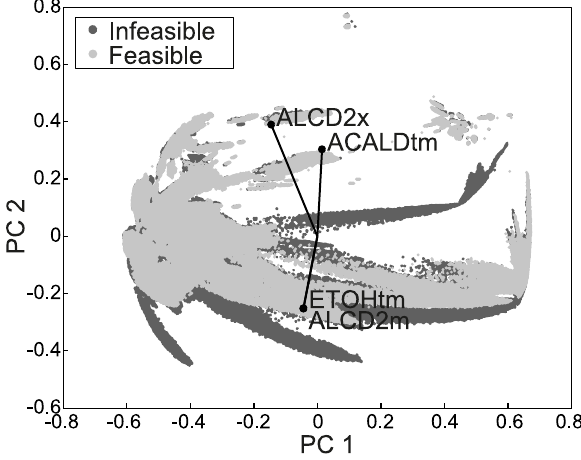
Figure 3. Principal component analysis on normalized EFMs represented in a matrix with each EFM as a sample and each reaction as a variable. All reaction rates are normalized to the glucose uptake rate of the respective EFM. The projection of the data (dots) for principal components one and two (PC 1 and PC 2), and the coefficients of the highest loadings in component 2 (labeled vectors) are shown. The reactions with highest loadings in PC 2 are likely to be involved in the causes for infeasibility of EFMs. One million EFMs were sampled to perform the PCA, multiple repeats with random sampling gave similar results.